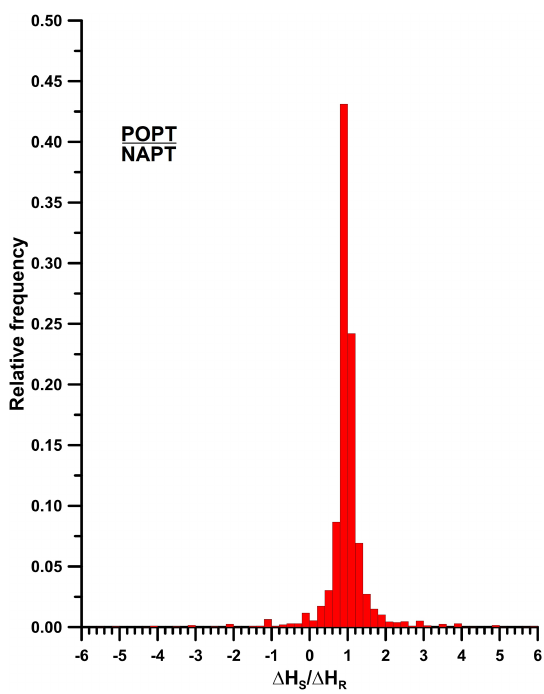
Figure 6. Frequency distribution of the R ratio between sea level daily variations at POPT station and NAPT tide gauge. Positive and negative values indicate that the signals are in phase or in phase opposition